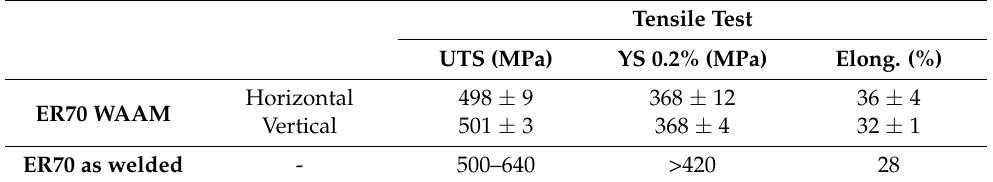
Table 3. Summary comparison of mechanical characterization on GMAW-ER70 wall on different directions.